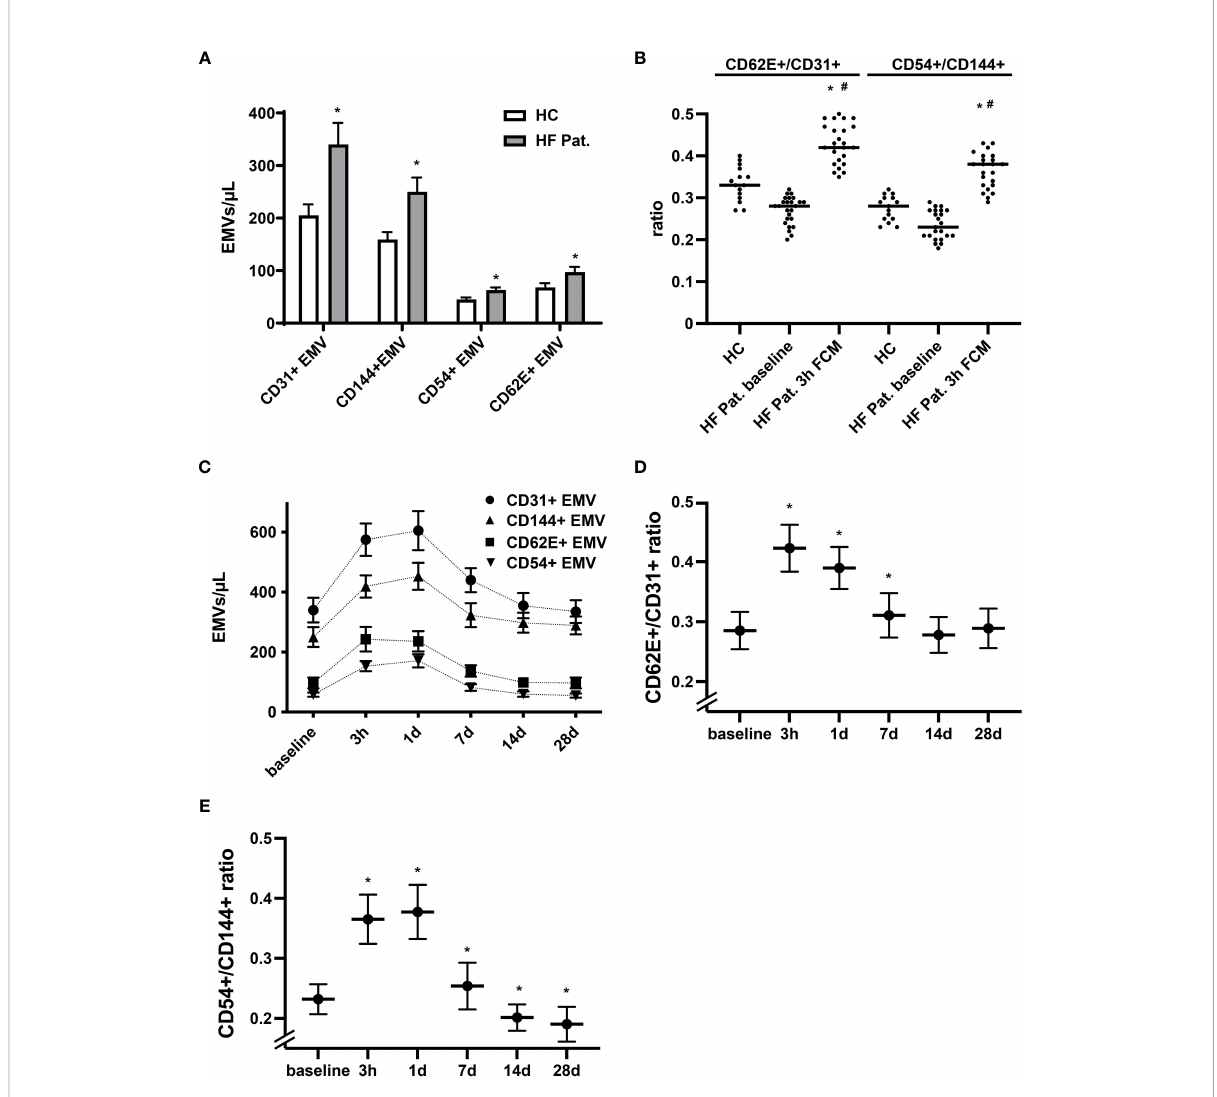
FIGURE 2 Dynamic alterations in the phenotype of circulating EMVs following FCM application. (A) Analysis of the phenotype of circulating EMVs with assessment of the constitutive endothelial markers CD31 (PECAM-1) and CD144 (VE-Cadherin) and the inducible markers CD62E (E-selectin) and CD54 (ICAM-1). *p < 0.05 vs. HF patients at baseline for the respective EMV phenotype. (B) Evaluation of the EMV CD62E+/CD31+ and CD54+/CD144+ ratio to determine the balance of activation vs. apoptosis related generation of EMVs. *p < 0.05 vs. the respective ratio in healthy controls, # p < 0.05 vs. the respective ratio in HF patients at baseline. (C) Kinetics of various EMV phenotypes following FCM injection in HF patients. Data points for each phenotype marker are connected by a broken line for the sole reason to enhance readability (D, E) Kinetics of the EMV CD62E+/CD31+ and CD54+/CD144+ ratio at baseline and following FCM injection in HF patients. *p < 0.05 vs. baseline for the respective EMV